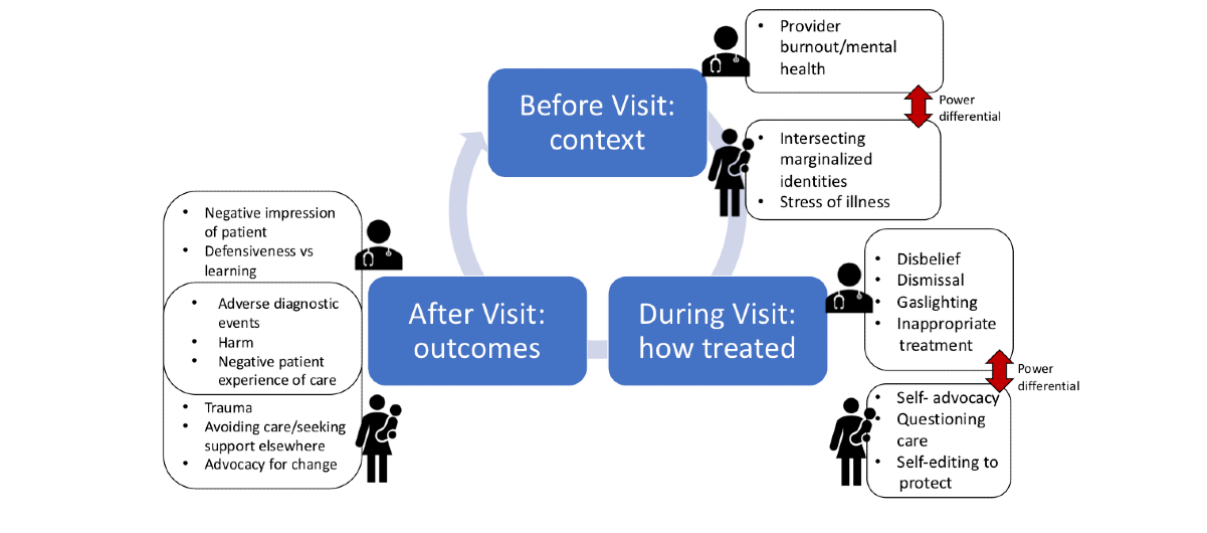
Figure 2. Cyclical process map of themes identified in Twitter